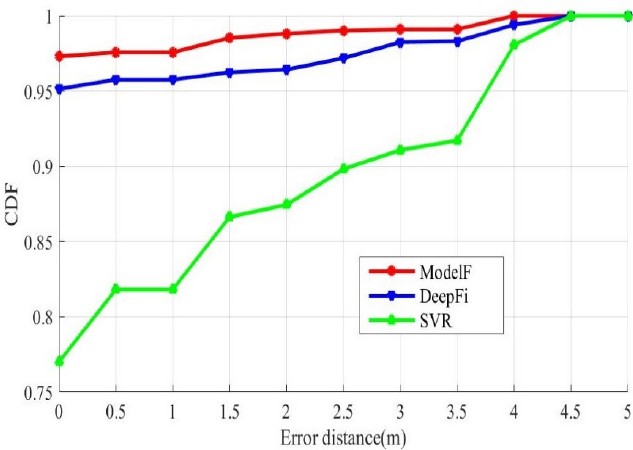
Figure 8. Localization precision of different method.